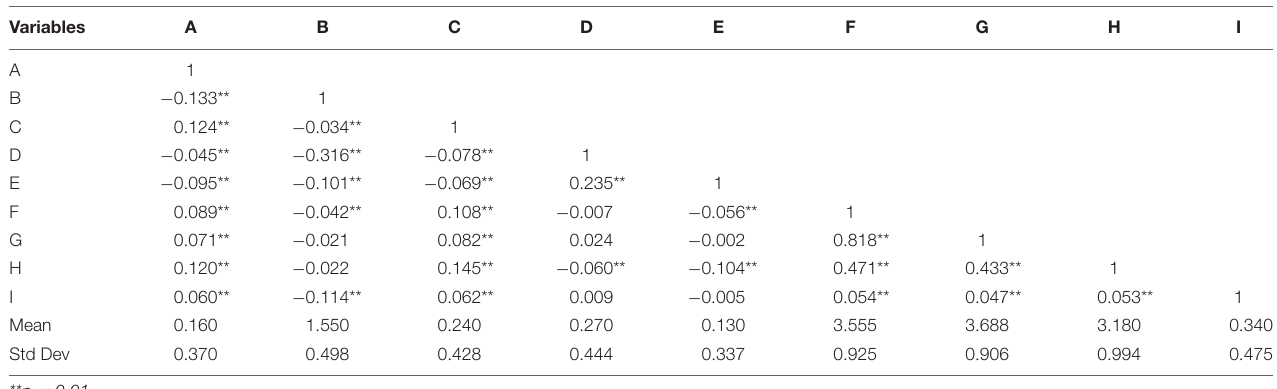
TABLE 4 | Statistical parameters for each variable.